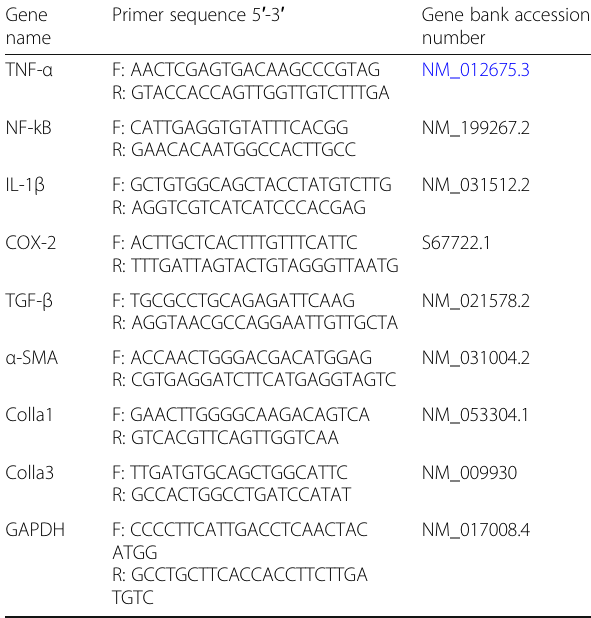
Table 1 The gene-specific primers used for RT-PCR